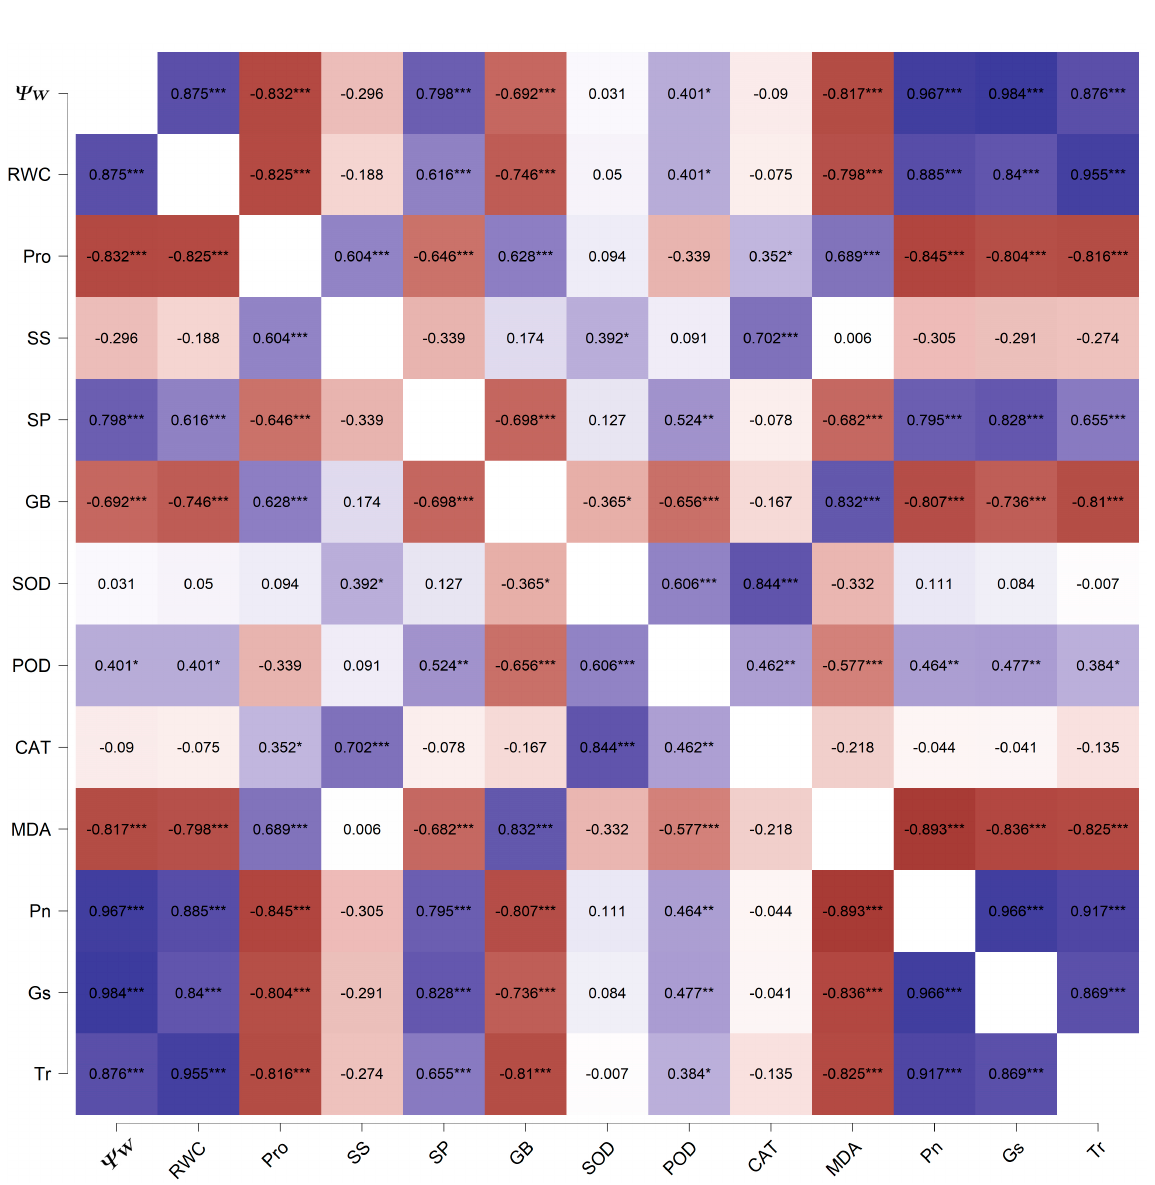
Figure 7. Correlation analysis among 13 physiological and biochemical indexes of four oak species under continuous drought stress and rehydration conditions. Ψ w: Water potential; RWC: Relative water content; Pro: proline; SS: soluble sugar; SP: soluble protein; GB: glycline betaine; SOD: superoxide dismutase; POD: peroxidase; CAT: catalase; MDA: malondialdehyde; Pn: net photosynthetic rate; Tr: transpiration rate; Gs: stomatal conductance. * p < 0.05, ** p < 0.01, and *** p < 0.001.